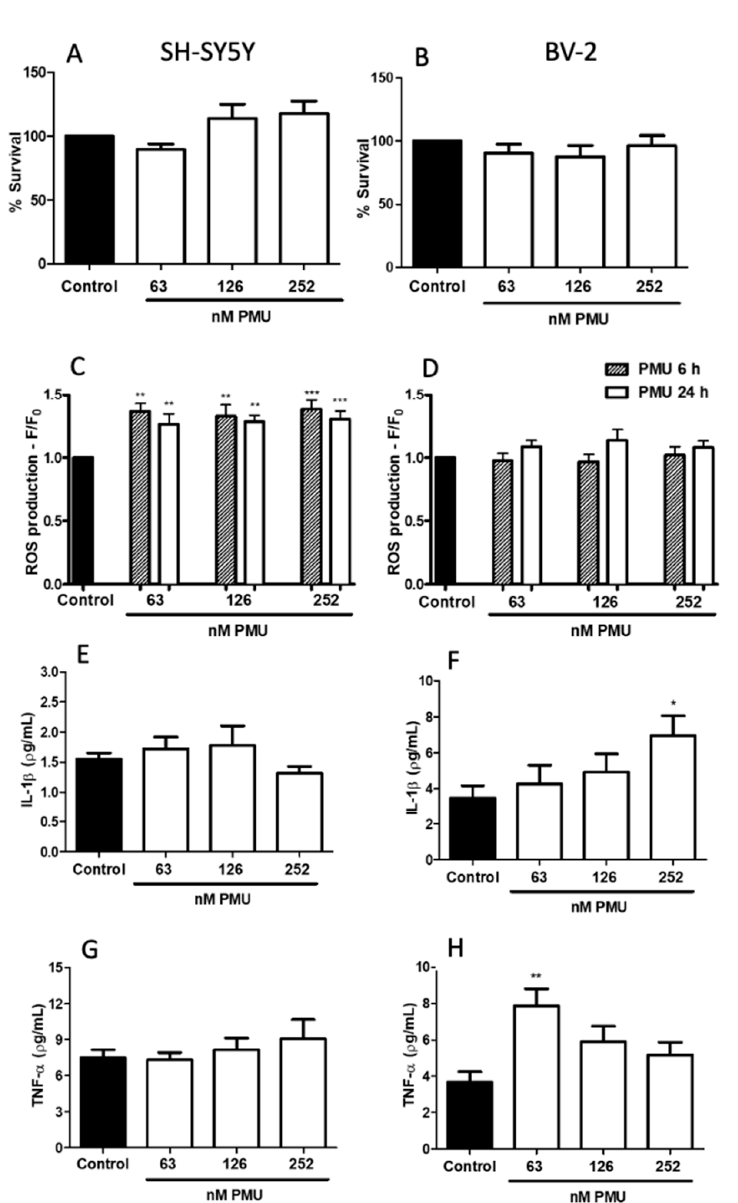
Figure 4. Neurotoxic and neuroinflammatory effects of Proteus mirabilis urease. Cultured neuroblas- toma, SH-SY5Y ( A , C , E , G ) or microglial, BV-2 ( B , D , F , H ) cells were incubated with NaPB 7.0 (control), or 63, 126 and 252 nM PMU for 6 h (hatched columns) and 24 h (open columns). In panels A , B , cell culture viability was analyzed 24 h after exposure to a buffer or PMU. After the treatments, cultures’ supernatants were removed and the cell pellets were treated with 100 µ L MTT (5 mg/mL) for 4 h at 37 ◦ C, then suspended in 100 µ L DMSO. Absorbances were read at 570 nm. Mean ± SEM ( n = 4–5 for the control and 5–8 for treatments). * p < 0.05, ** p < 0.01 and *** p < 0.001 vs. control. In panels C , D , intracellular production of reactive oxygen species was assessed by pre-incubation of the cells with fluorophore CM-DFFDA (2 mM, 30 min) before exposure to a buffer or PMU, followed by fluorescence analysis (excitation 495 nm, emission 527 nm). Mean ± SEM ( n = 5–10, controls; n = 5–16 for treatments) * p < 0.05, ** p < 0.01, *** p < 0.001 vs. control. In panels E – F , after incubation for 6 h with NaPB 7.0 (control) or PMU (63, 126, 252 nM) of SH-SY5Y ( E , G ), or BV-2 ( F , H ) cell cultures, the supernatants were collected for detection of IL-1 β ( E , F panels) and TNF- α ( G , H panels) by ELISA. The data were analyzed by one-way parametric ANOVA with a Dunnett post-test, the results are the mean ± SEM ( n = 4–6 for the control and 3–6 for treatments). * p < 0.05 and ** p < 0.001 vs.